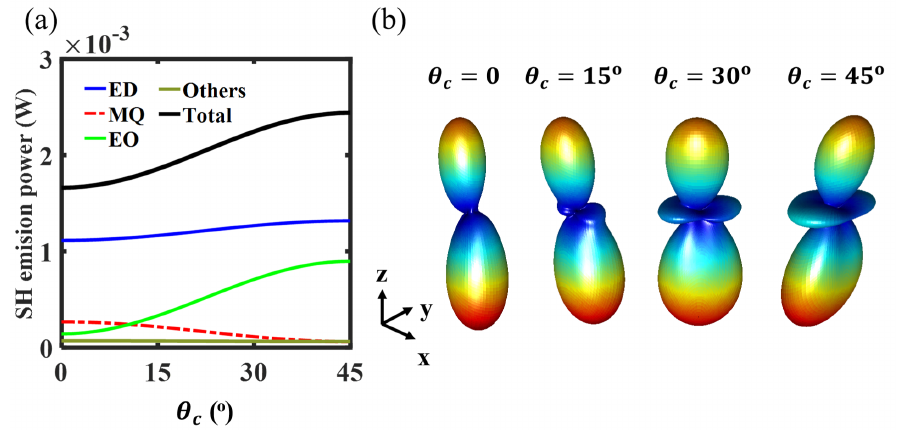
Figure 5. Nonlinear emission under oblique pump incidence with θ = 45 ◦ . ( a ) Nonlinear multipolar excitation for different rotating angle θ c ; ( b ) the far-field patterns for different rotating angle θ c